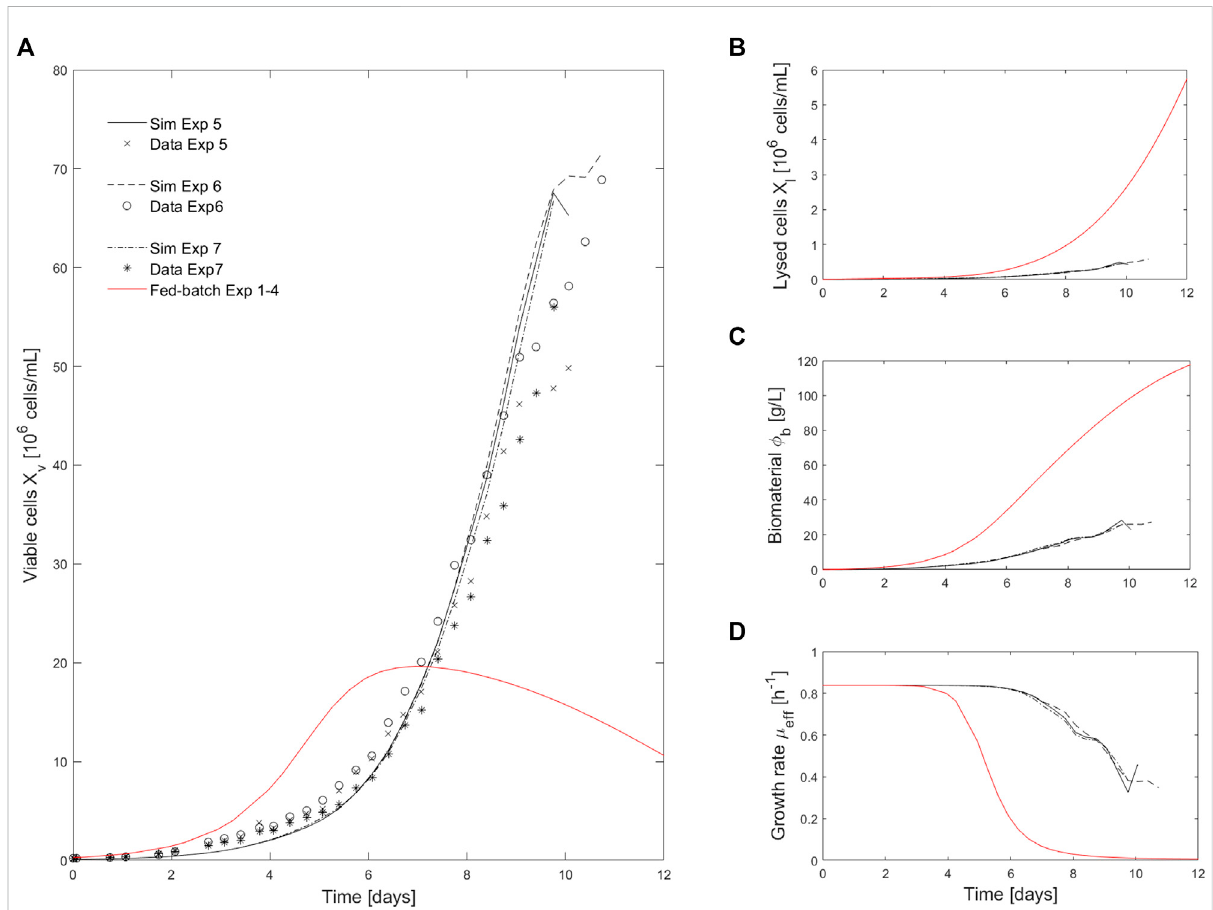
FIGURE 3 Comparison of intensi fi ed (media exchange) and fed-batch experiments. (A) . Comparison of viable cell density ( X v ) measurement of intensi fi ed cultures 5-7 (black cross, star and open circle) with the model simulation of the intensi fi ed culture (solid black line) and the fed-batch culture (solid red-line) performedusing theparameters value identi fi edon thewhole setof fed-batch experiments 1-4. (B – D) present, respectively, acomparison of the lysed cells density ( X l ), biomaterial concentration ( ∅ b ) and growth rate ( μ eff ) simulated for the intensi fi ed culture (solid black line) and the